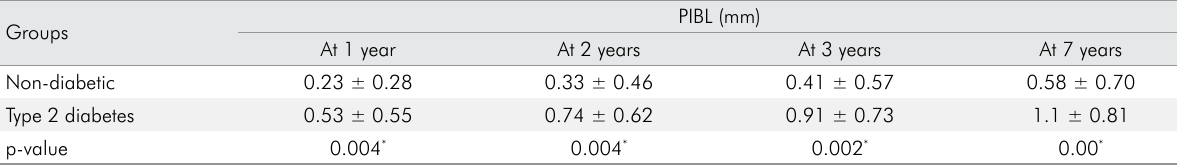
*Denotes statistically significant p-value obtained by the Mann-Whitney U test.